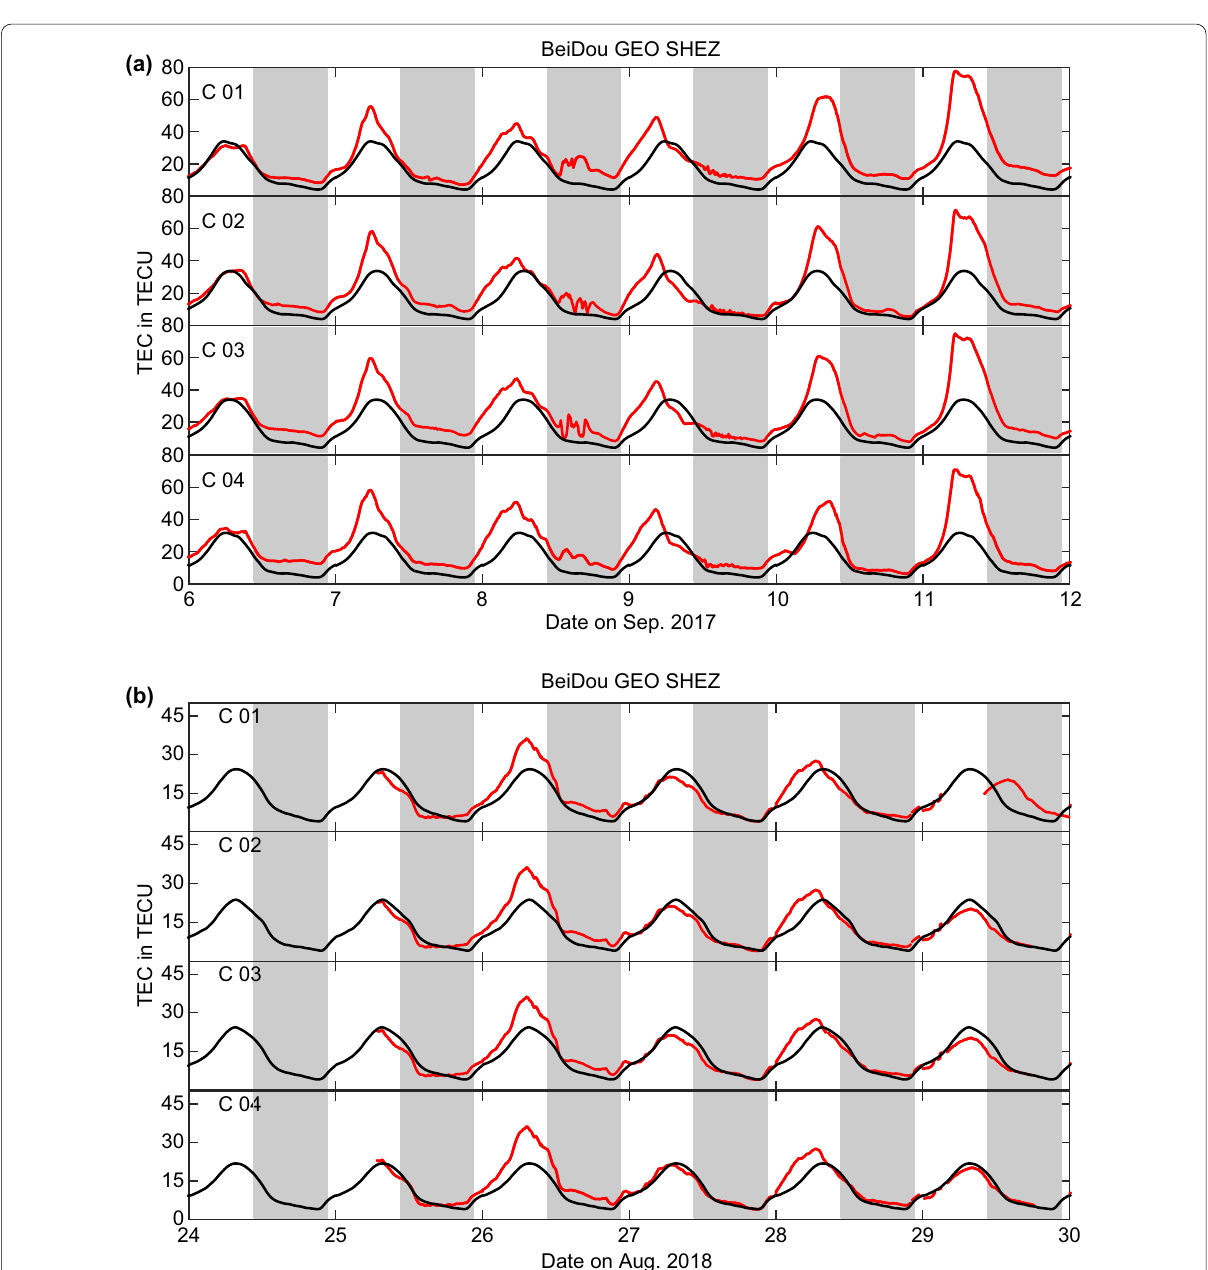
Fig. 5 The BeiDou GEO (C01-04) derived TEC (red) at the station SHEZ during geomagnetic storms on a 6–11 September 2017 and b 24–29 August 2018. The quiet-time references are represented in black lines. The grey shadow area represents the night side between 18:00–06:00